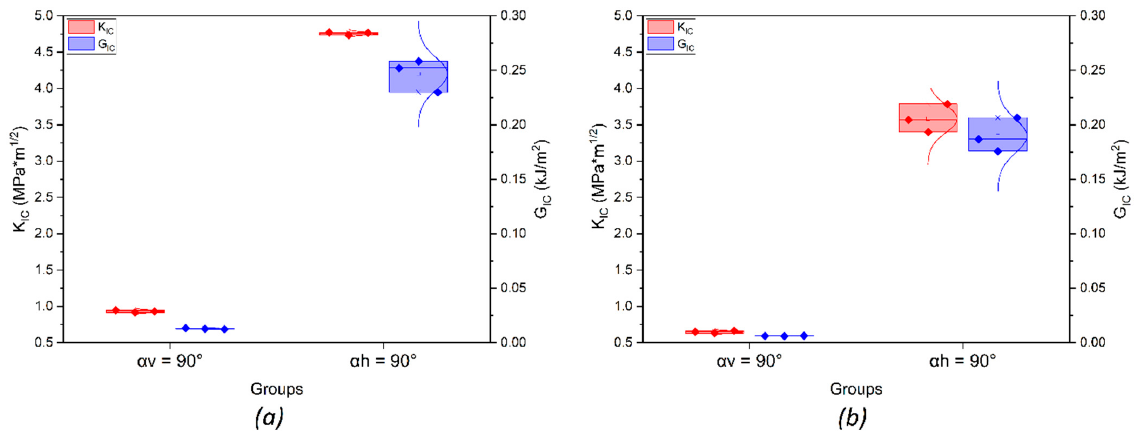
Figure 14. Results for stress intensity factor and critical strain energy release rate for samples with ( a ) and without ( b ) heat treatment. Table 6. Critical stress intensity factor, critical strain energy release rate and tensile strength ob- tained in CT tests.